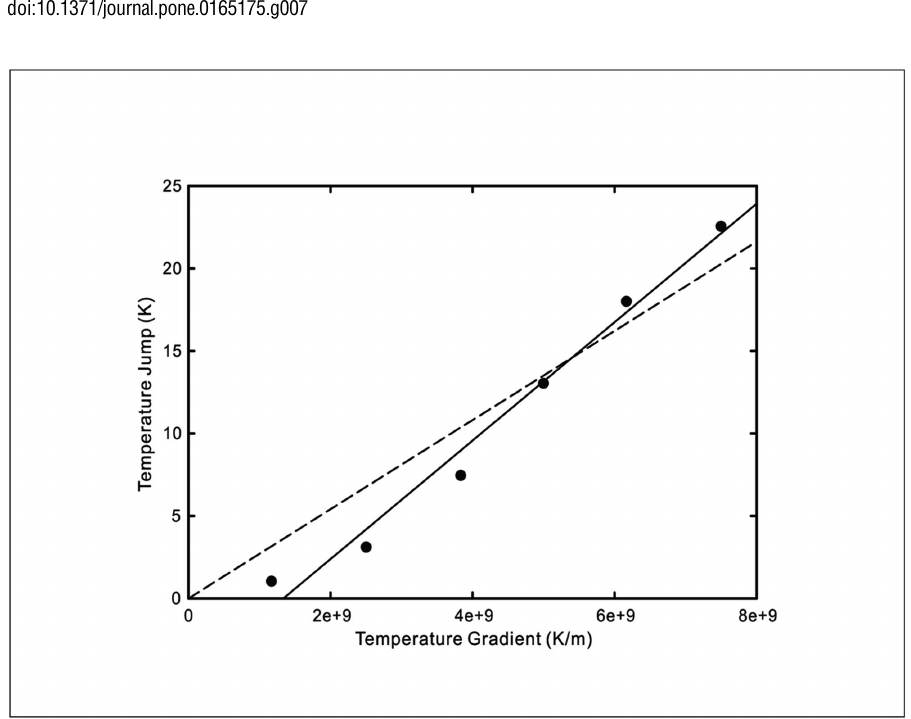
Fig 8. Temperature jump as a function of wall temperature gradient at a silica-SAM-water interface. Symbols: MD simulation results [18]. Solid line: New temperature jump model from Eq 8 with C 1 = 3.59 × 10 − 9 and C 2 = 0.015 for T w = 326 K . Dashed line: Existing temperaturejump model from Eq 11 with C = 2.704 × 10 − 9